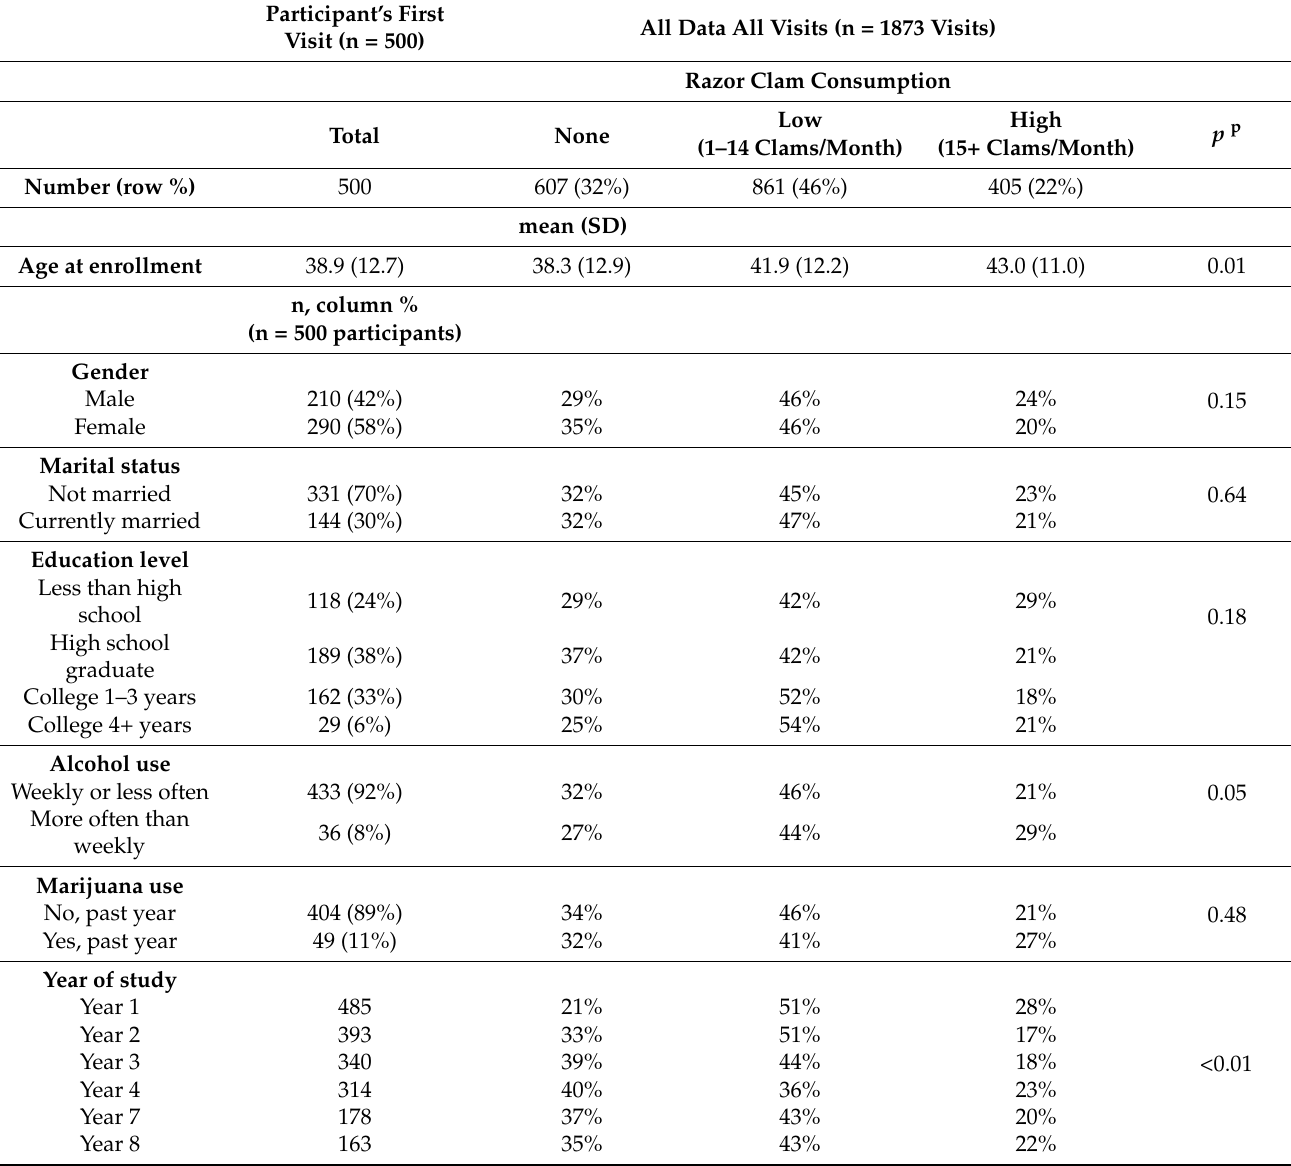
Table 1. Baseline characteristics and razor clam